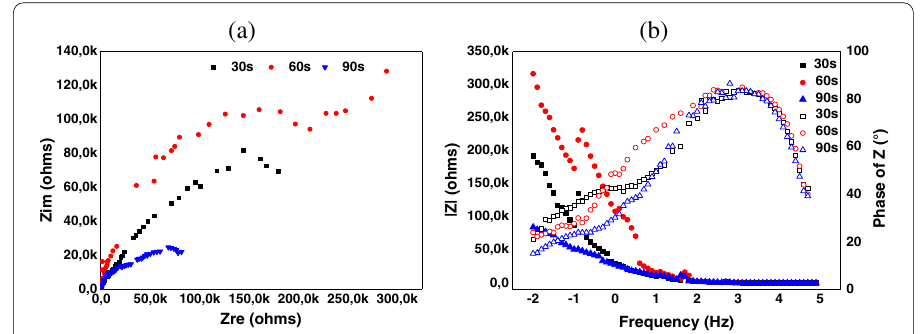
Fig. 11 The impedance curve of the different time of pre-oxydation according to the representation of a Nyquist plots and b Bode plots in 3.5% NaCl